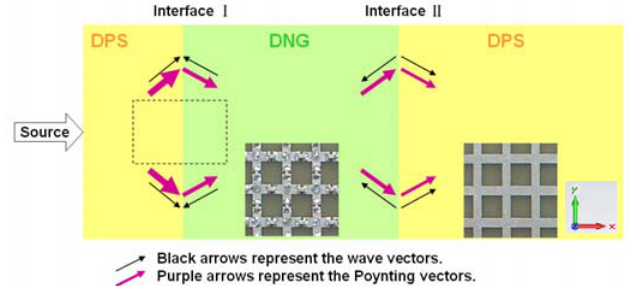
Figure 1: Structure of the metamaterial lens.